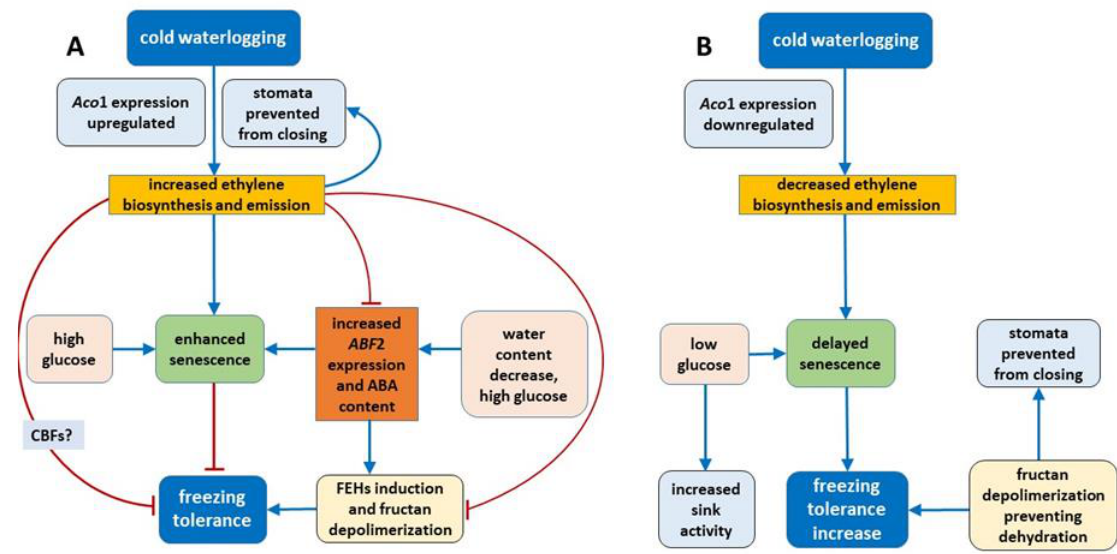
Figure 14. Proposed mechanism of change in freezing tolerance under cold waterlogging in Lolium perenne ( A ) genotypes that showed no freezing tolerance increase; ( B ) genotypes that increased freezing tolerance. Blue lines represent positive regulation. Red lines indicate negative regulation.